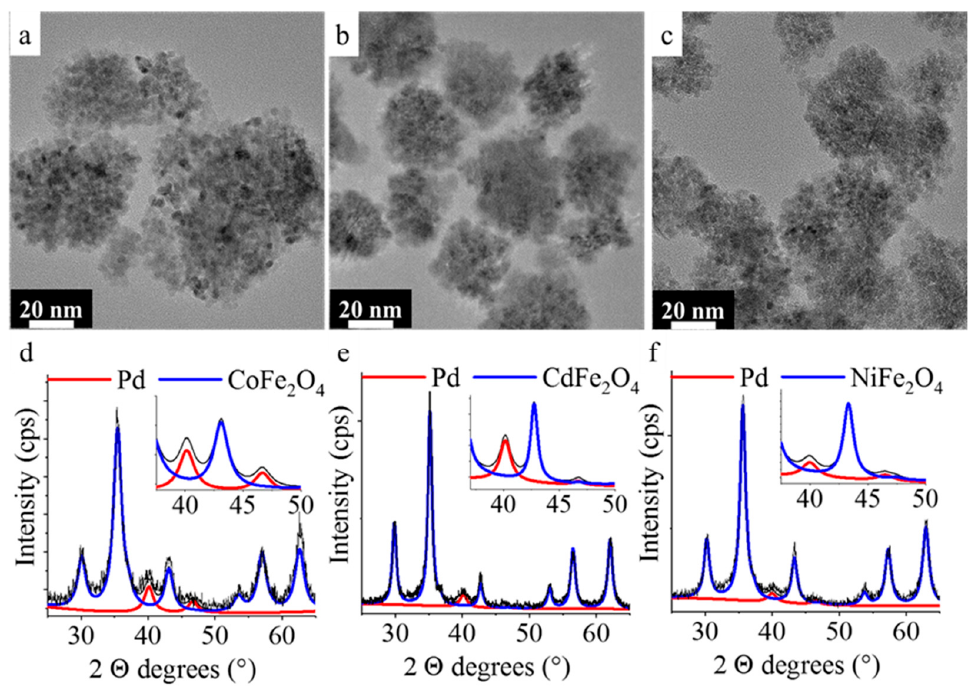
Figure 4. HRTEM pictures and XRD patterns of the Pd/CoFe 2 O 4 -NH 2 ( a , d ), Pd/CdFe 2 O 4 -NH 2 ( b , e ), and Pd/NiFe 2 O 4 -NH 2 catalysts ( c , f ).